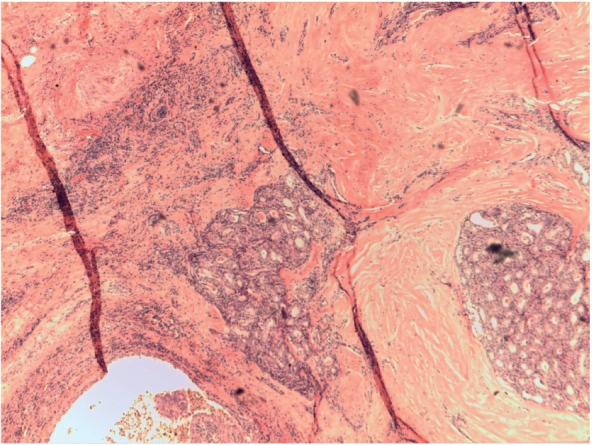
Papillary carcinoma with sclerosing X10 magnification.